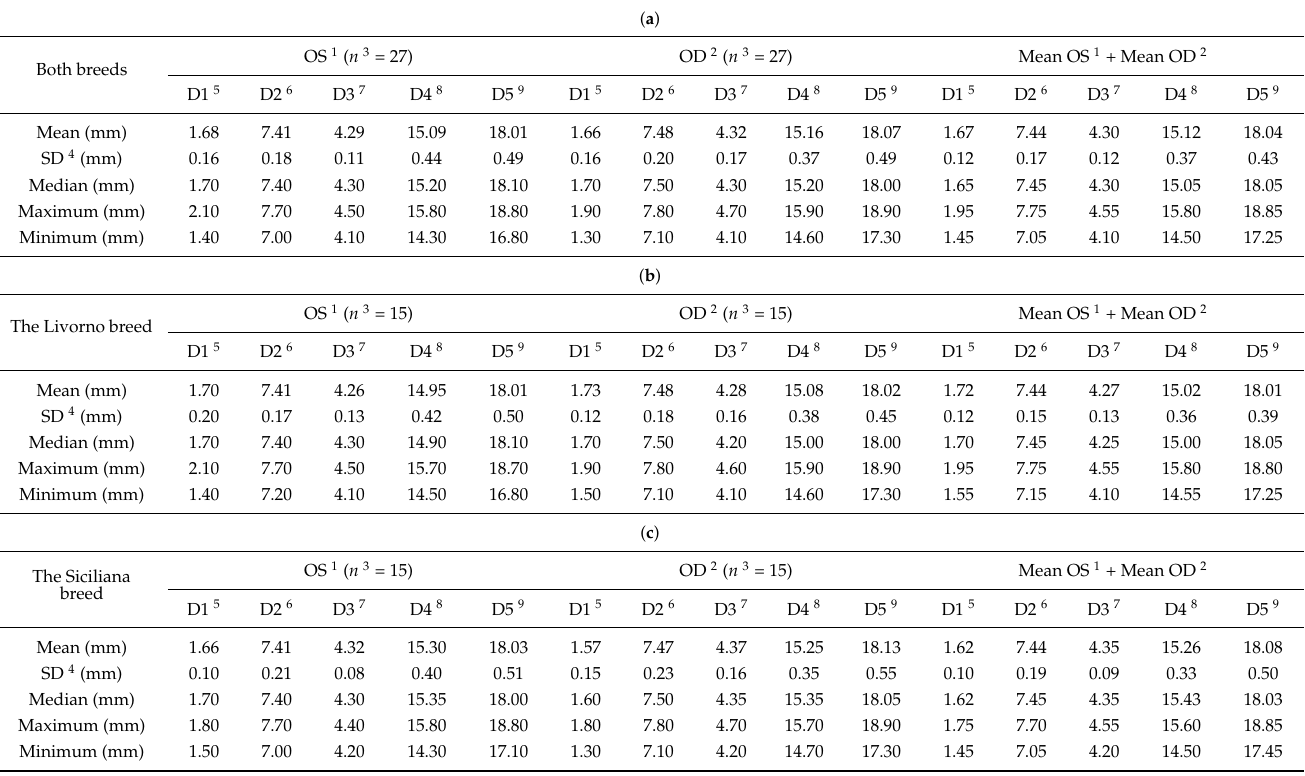
Figure 3. The transverse length of the globe (D5). Table 3. ( a ) Morphometric results in both breeds; ( b ) morphometric results in the Livorno breed; ( c ) morphometric results in the Siciliana breed.